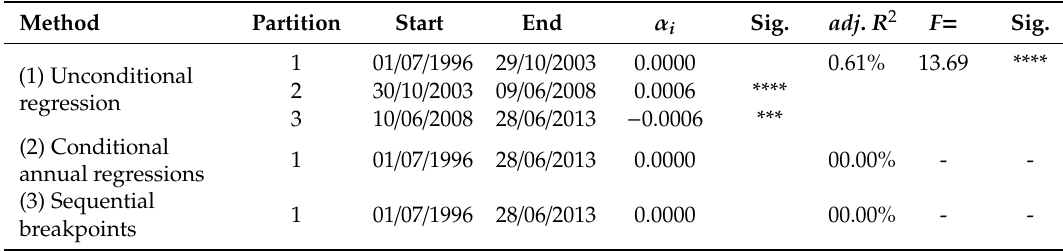
Table 6. Bai and Perron (2003) breakpoint